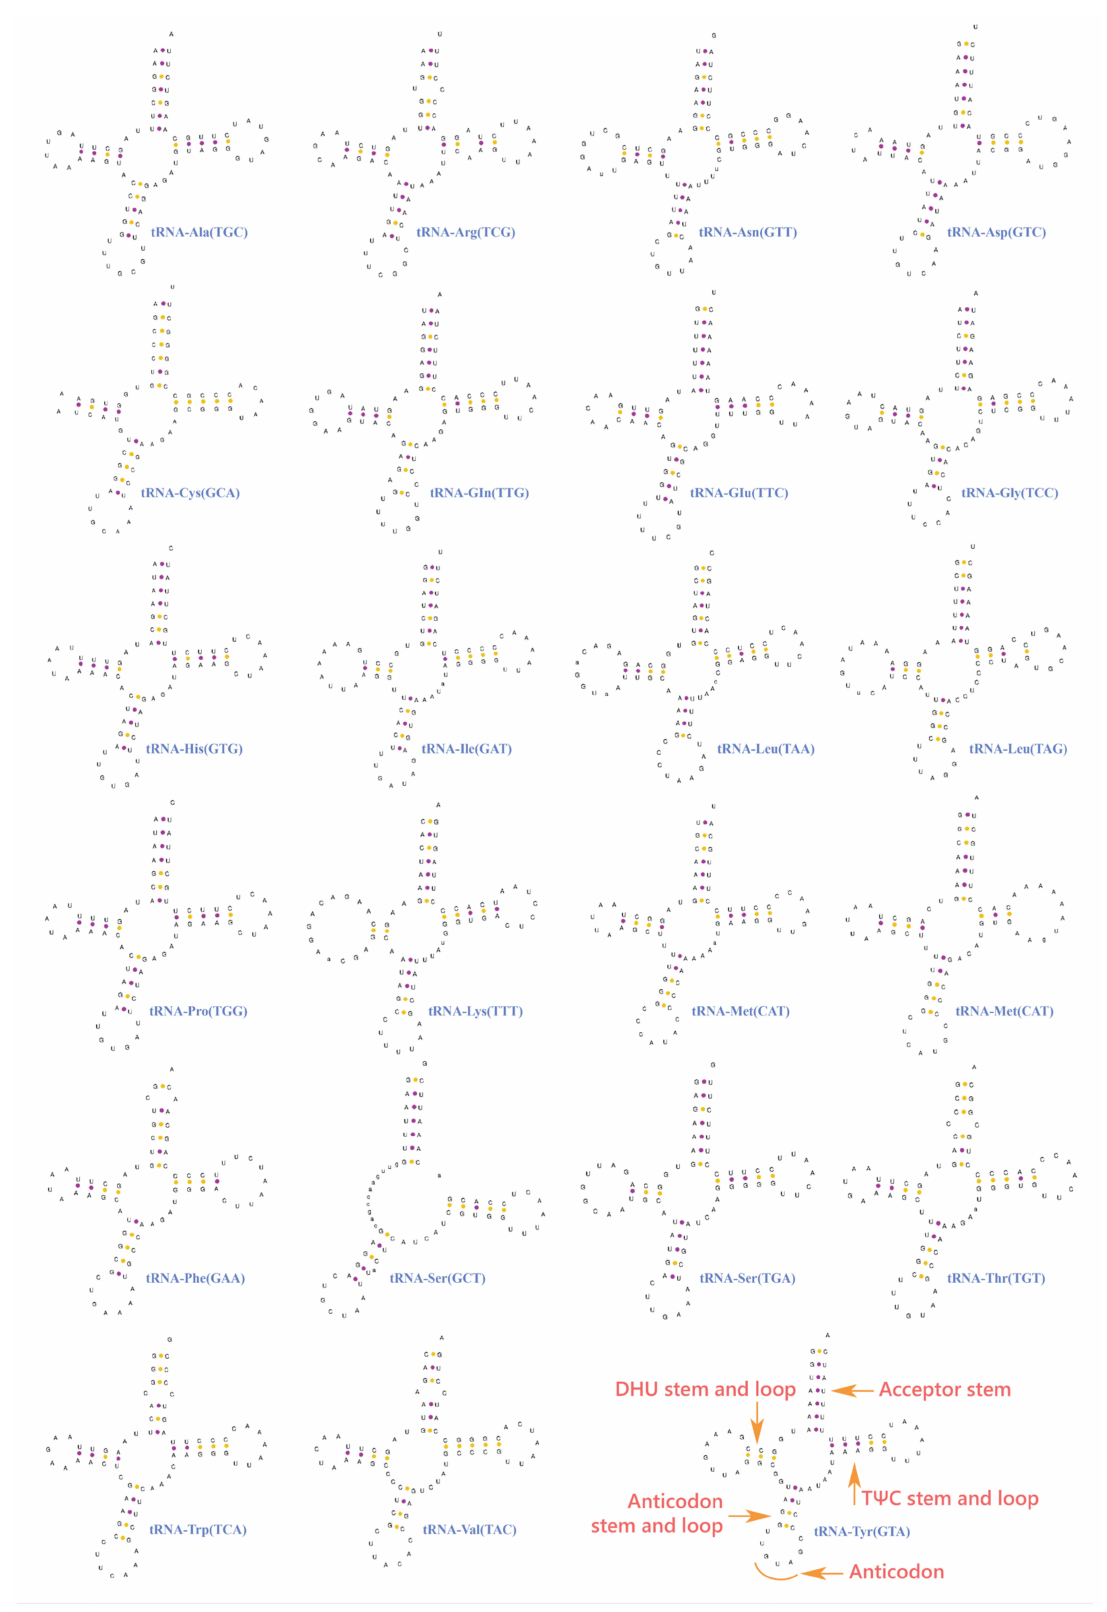
Figure 3. Putative secondary structures for 23 tRNA genes of Oreolalax omeimontis